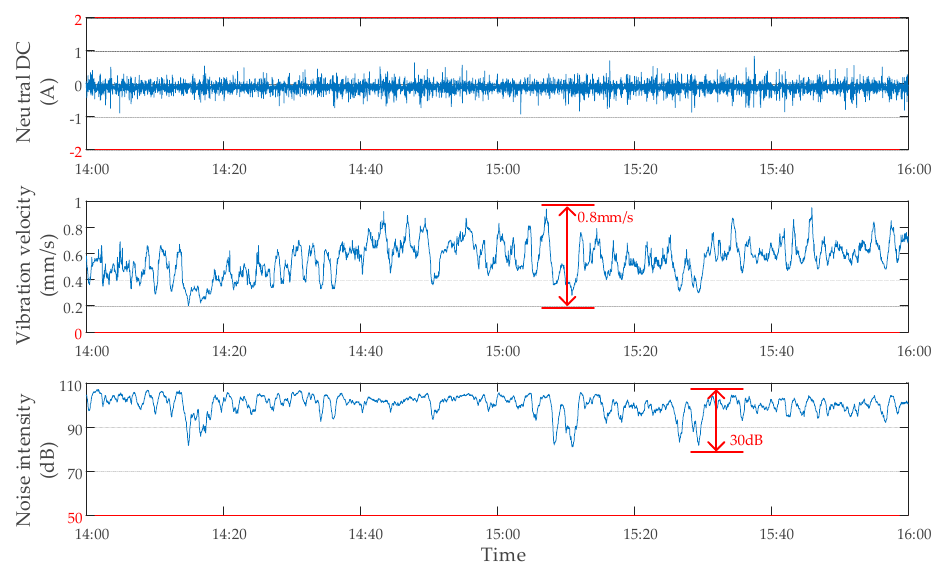
Figure 8. The data characteristics of a transformer with DC bias and suppression device on.